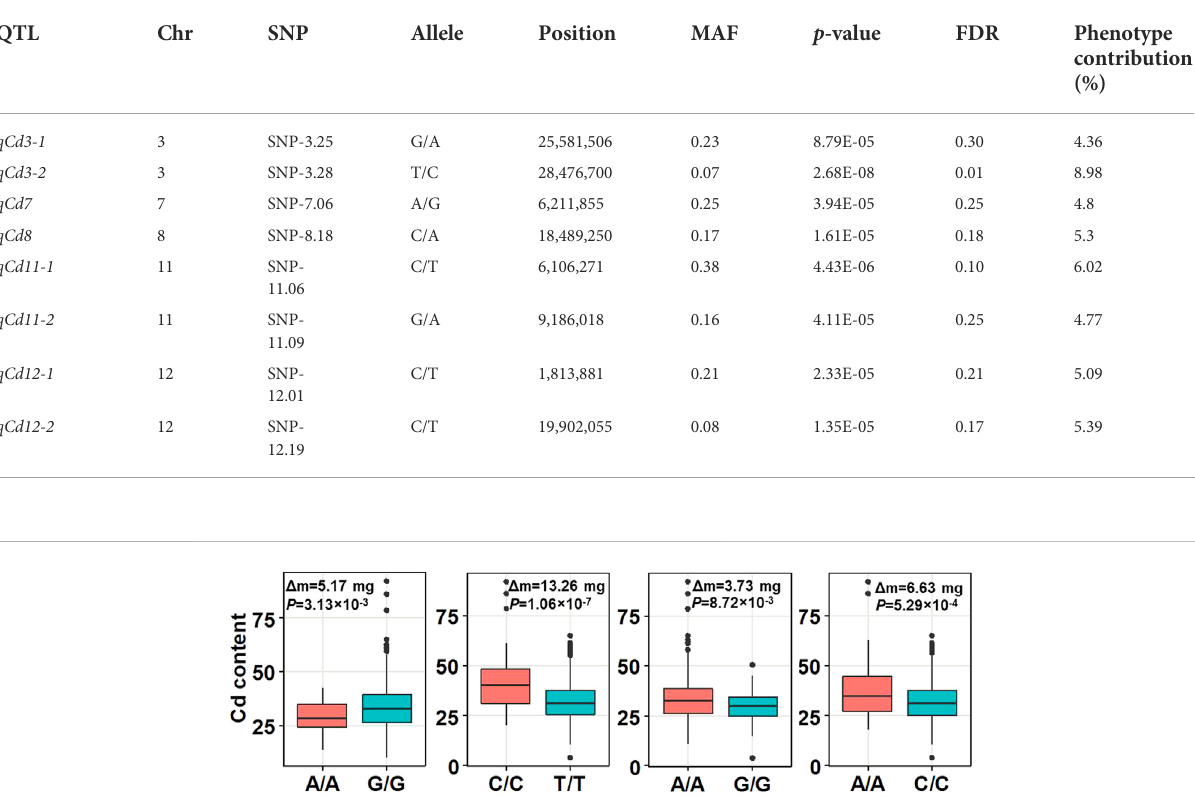
TABLE 2 QTLs associated with Cd accumulation identi fi ed by the GWAS.